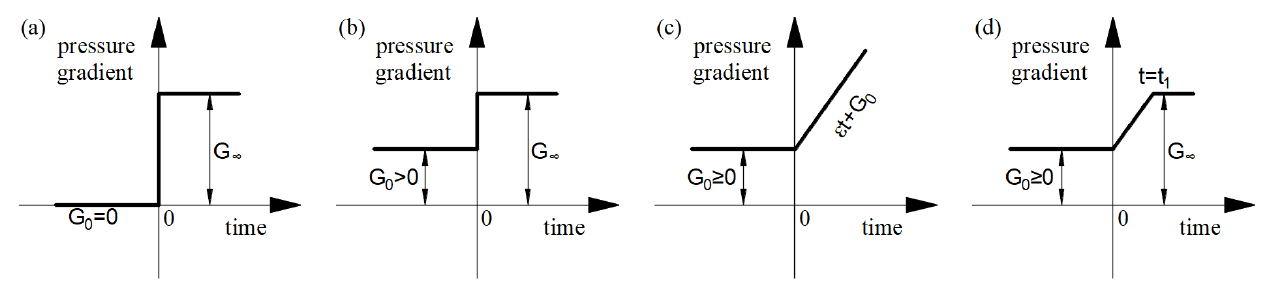
Figure 2. Changes of pressure gradients: ( a ) step change from rest, ( b ) step change from initial to final value, ( c ) linear increase ( d ) ramp change.